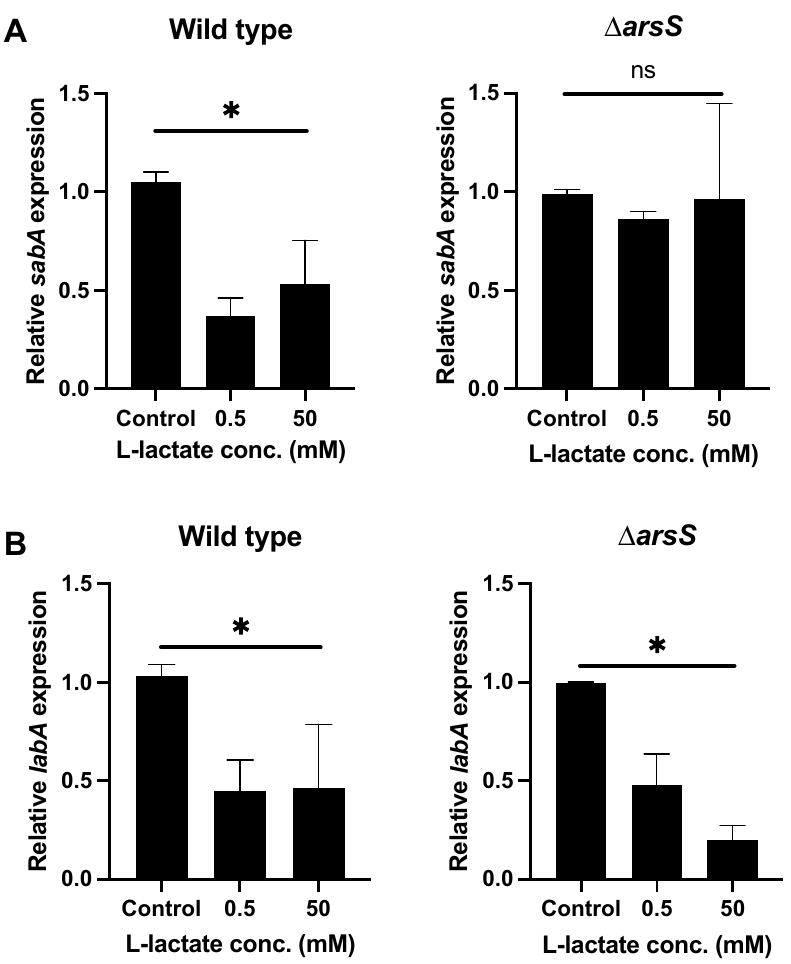
Figure 4. The lactate-mediated downregulation of sabA expression is dependent on the ArsRS two-component system. Relative expression levels of sabA ( A ) and labA ( B ) in wild-type and ∆ arsS mutant H. pylori after incubation of the bacteria in RPMI 1640 medium without glucose (control) or supplemented with 0.5 mM or 50 mM l-lactate for 2 h. Target gene expression was normalized to that of the housekeeping gene gyrB . Wild- type and ∆ arsS mutant bacteria were analyzed with their respective controls set to 1 to determine the relative values of sabA and labA expression in each of the samples incubated with lactate. Data represent the means and standard deviation of duplicate samples and are an average of three independent experiments. *P < 0.05; ns, nonsignificant, using ANOVA followed by a Bonferroni